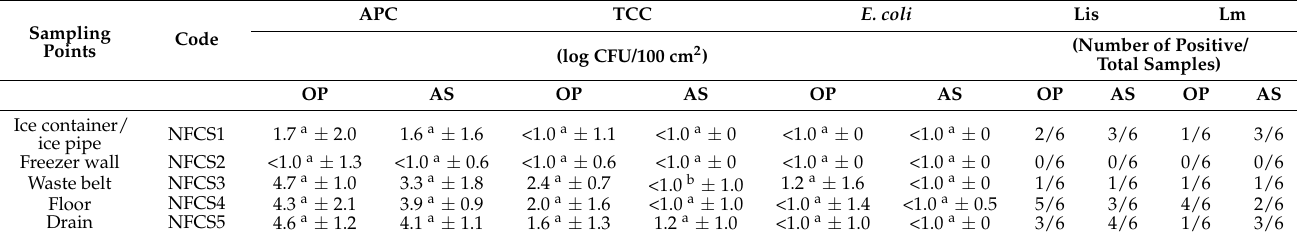
Table 4. Aerobic plate count (APC), total coliform count (TCC), generic E. coli count, Listeria spp. (Lis) and Listeria monocytogenes (Lm) levels on non-food contact surfaces (NFCS) during operation (OP) and after cleaning and sanitation